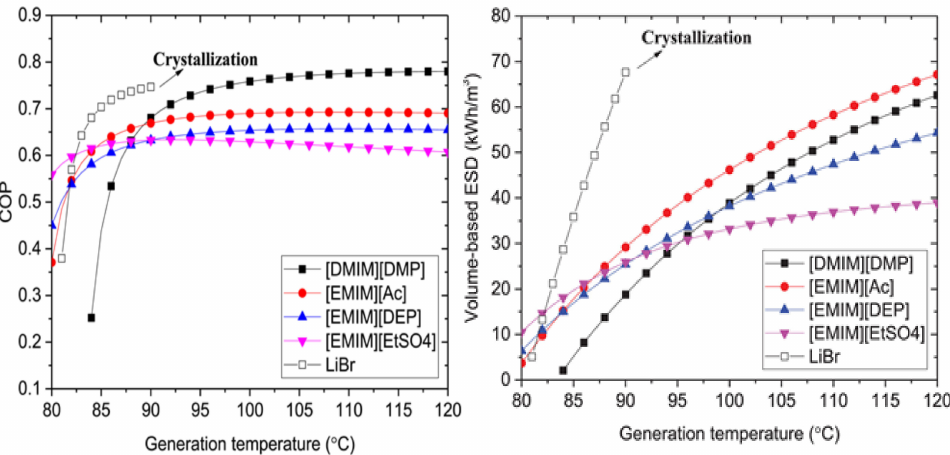
Figure 6. Performance analysis of ILs/H 2 O mixtures in absorption thermal energy storage for different generation temperatures